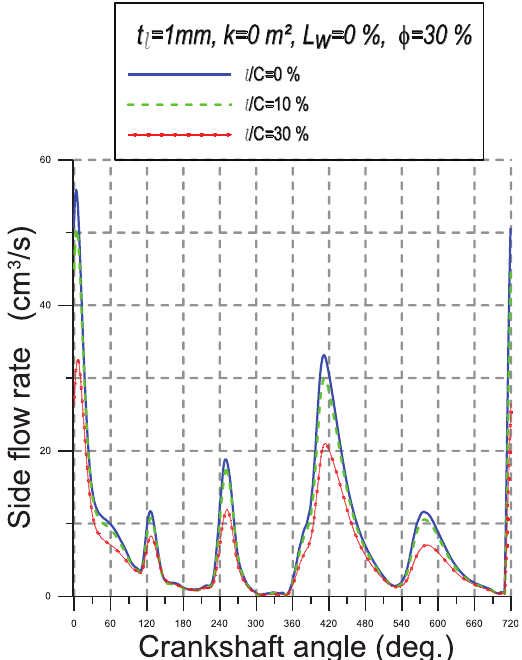
Fig. 17. Effects of the particle size parameter on side leakage fl ow over an engine cycle.